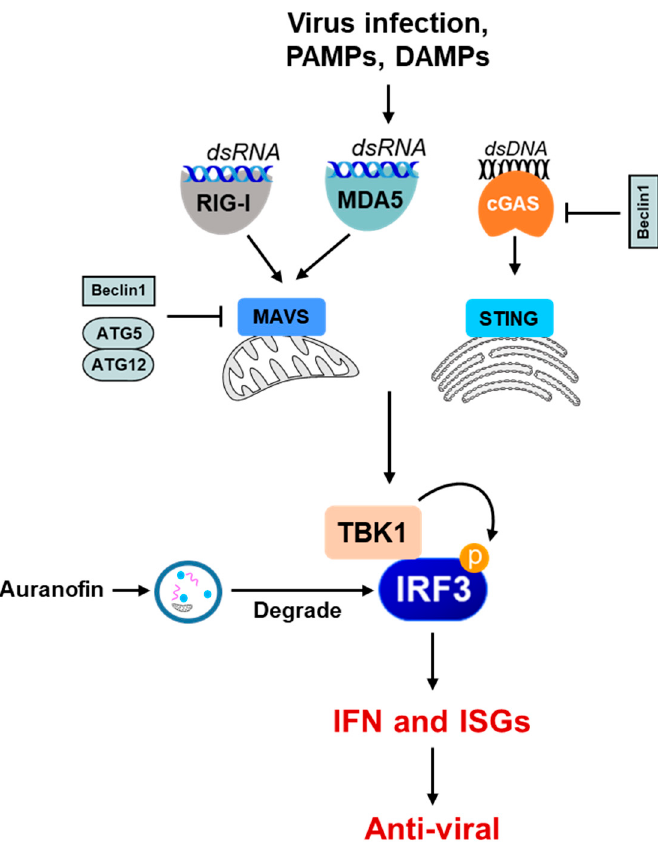
Figure 4. The role of autophagy in the negative regulation of the innate immune signaling pathway.